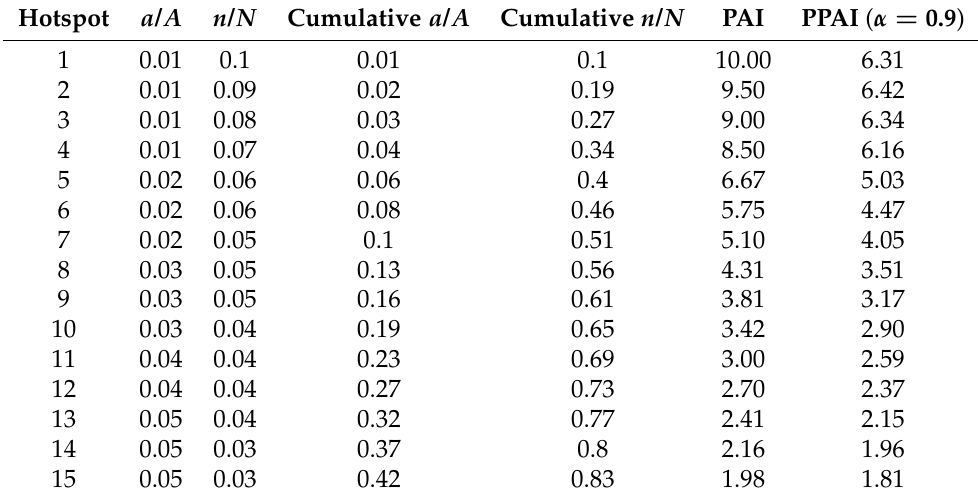
Table 3. The relative area and hit rate, the cumulative area and hit rates as well as the PAI and PPAI (for α = 0.9) for the cumulative hotspot